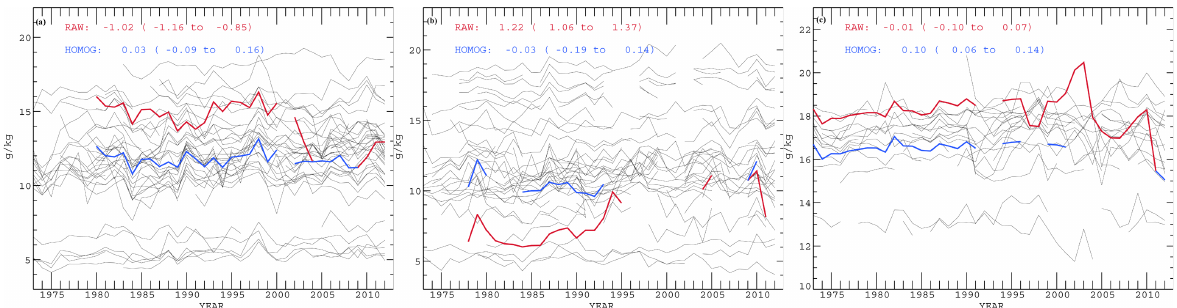
Fig. 6. Results for three stations as examples of some of the largest changes of the pairwise homogenisation algorithm. Red lines represent the original station time series. Blue lines represent the adjusted time series. Black lines show the original time series for all stations within the designated network. (a) Sur, Oman, WMO ID: 412680, 22.533 ◦ N, 59.467 ◦ E, 14.0m. (b) Atar, Mauritania, WMO ID: 614210, 20.5170 ◦ N,